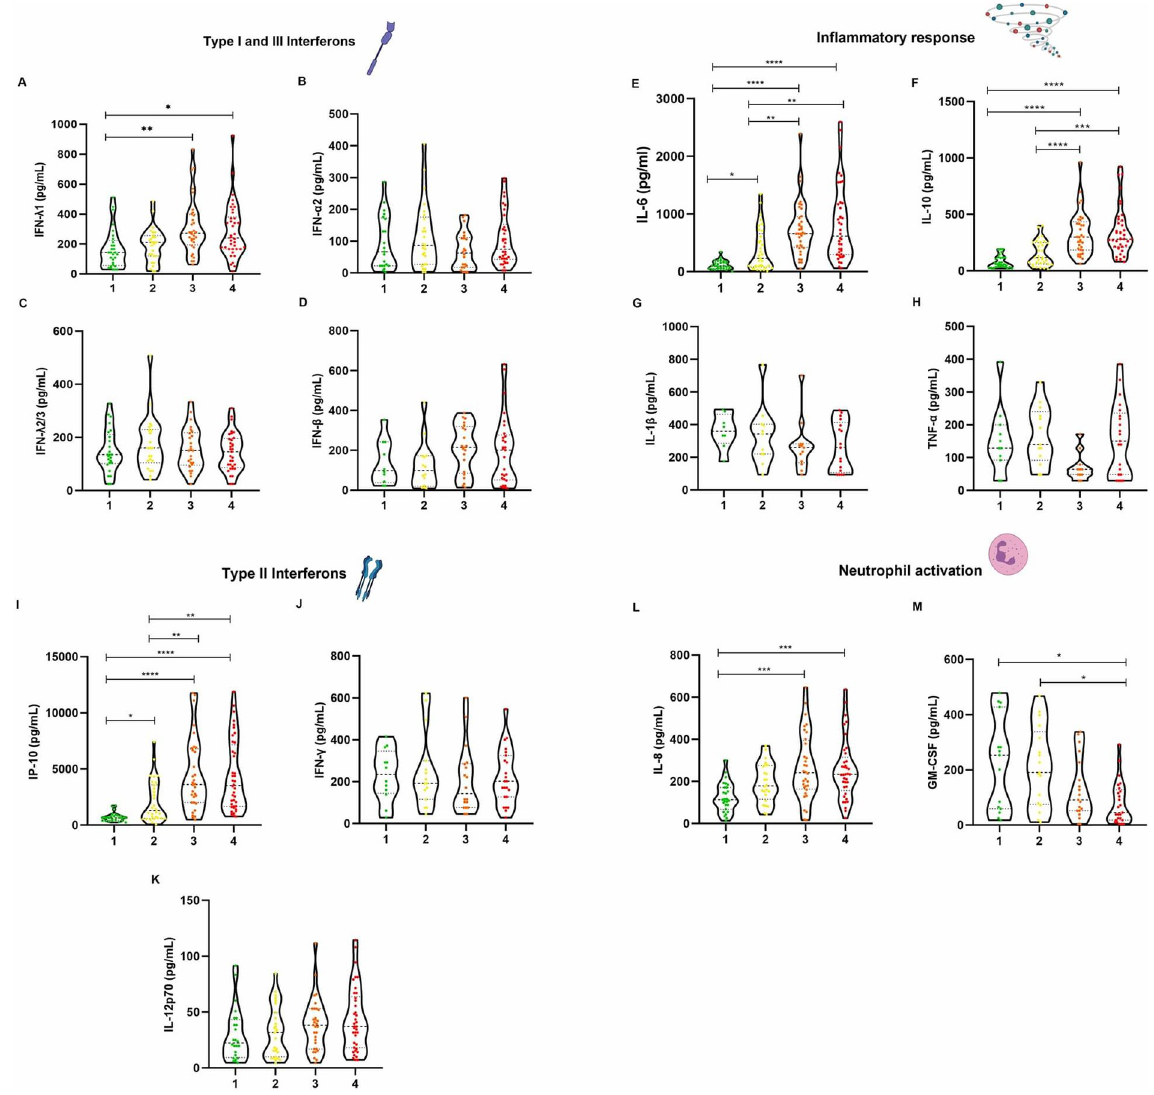
Fig 2. Plasma concentration of types I, II and III interferon response cytokines, inflammatory response cytokines, and neutrophil response cytokines. (A) IFN- λ 1 (B) IFN- α 2(C) IFN- λ 2/3 (D) IFN- β (E) IL-6(F) IL-10 (G) IL-1 β (H) TNF- α (I) IP-10 (J) IFN- γ (K) IL-12p70 (L) IL-8 (M) GM-CSF. All measurements were made using a multiplex flow cytometry assay (LEGENDplex). Results were obtained in a BD FACS Canto II flow cytometer and processed using the LEGENDplex Data Analysis Software v8.0. Graphs were constructed in GraphPad Prism v8.0. The � p value < 0.05, �� p value < 0.01, ��� p value < 0.001 and ���� p value < 0.0001 was calculated using Kruskall Wallis tests with a Dunn´s